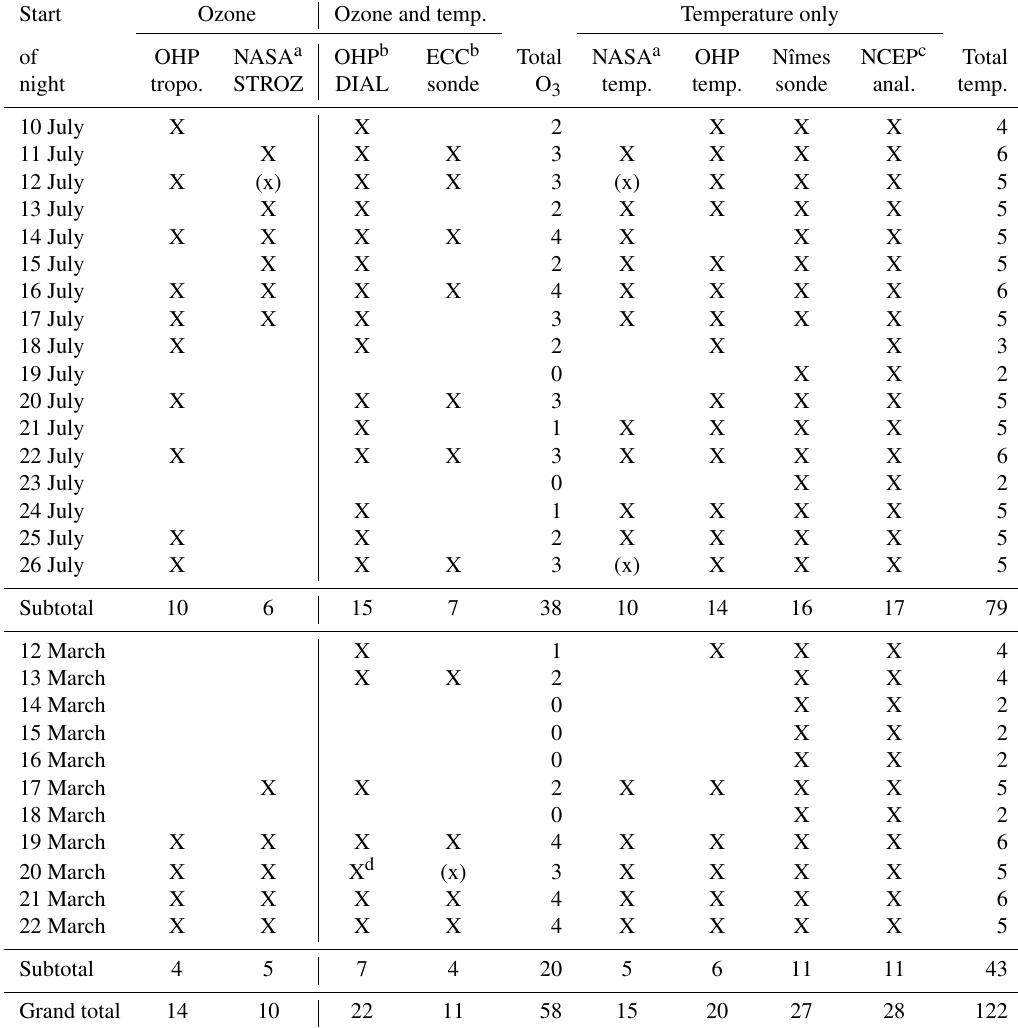
Table 2. Measurement dates for the ground-based instruments during the LAVANDE campaign in July 2017 and March 2018. The lidar measurements require nighttime conditions and averaging over several hours. The dates give the beginning of these nights. X denotes a valid measurement for the given night. (x) denotes a measurement that appeared faulty and was not used in the later statistical analysis. Satellite profiles of ozone and temperature are available for all